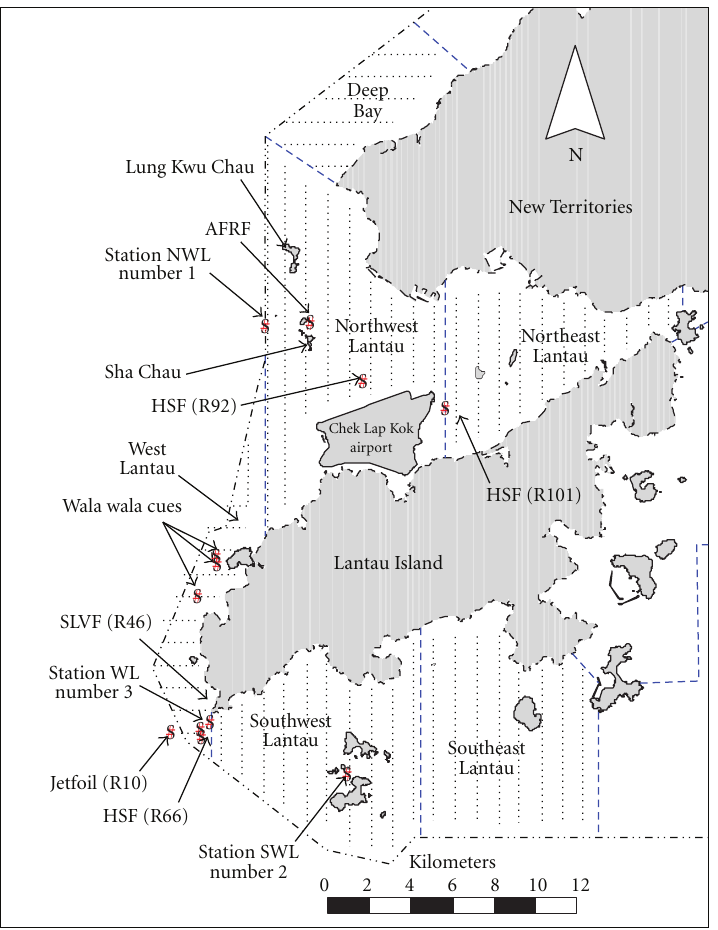
Figure 1: A map of Lantau Island in Hong Kong with recording stations, recording locations, and transects. The letter “R” and the following number correspond to the individual recording number associated with the location name. “HSF” stands for an unidentified high-speed ferry, “Jetfoil” is the name of an identified high-speed ferry, and “Wala wala” is an arbitrary name associated with the small tour boats in the area. The “SLVF” is the South Lantau Vessel Fairway and the “AFRF” is the retired Aviation Fuel Receiving